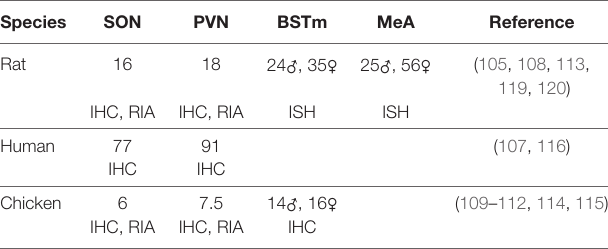
TABLe 1 | Earliest day postfertilization of arginine vasotocin (AVT)/arginine vasopressin labeling found.